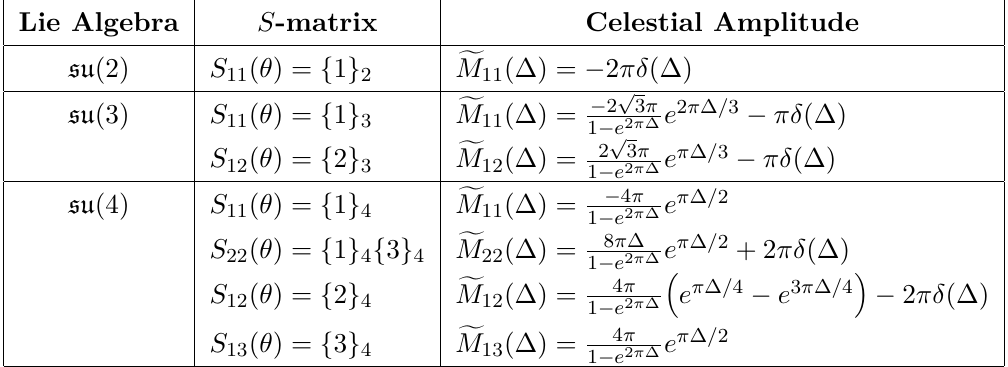
Table 1 . Celestial amplitudes for the perturbed coset theories with g = su (2) , su (3) , and su (4) . There is an additional symmetry exchanging particles 1 ↔ 2 in the su (3) theory and 1 ↔ 3 in the su (4) theory relating the amplitudes in the above table to the other